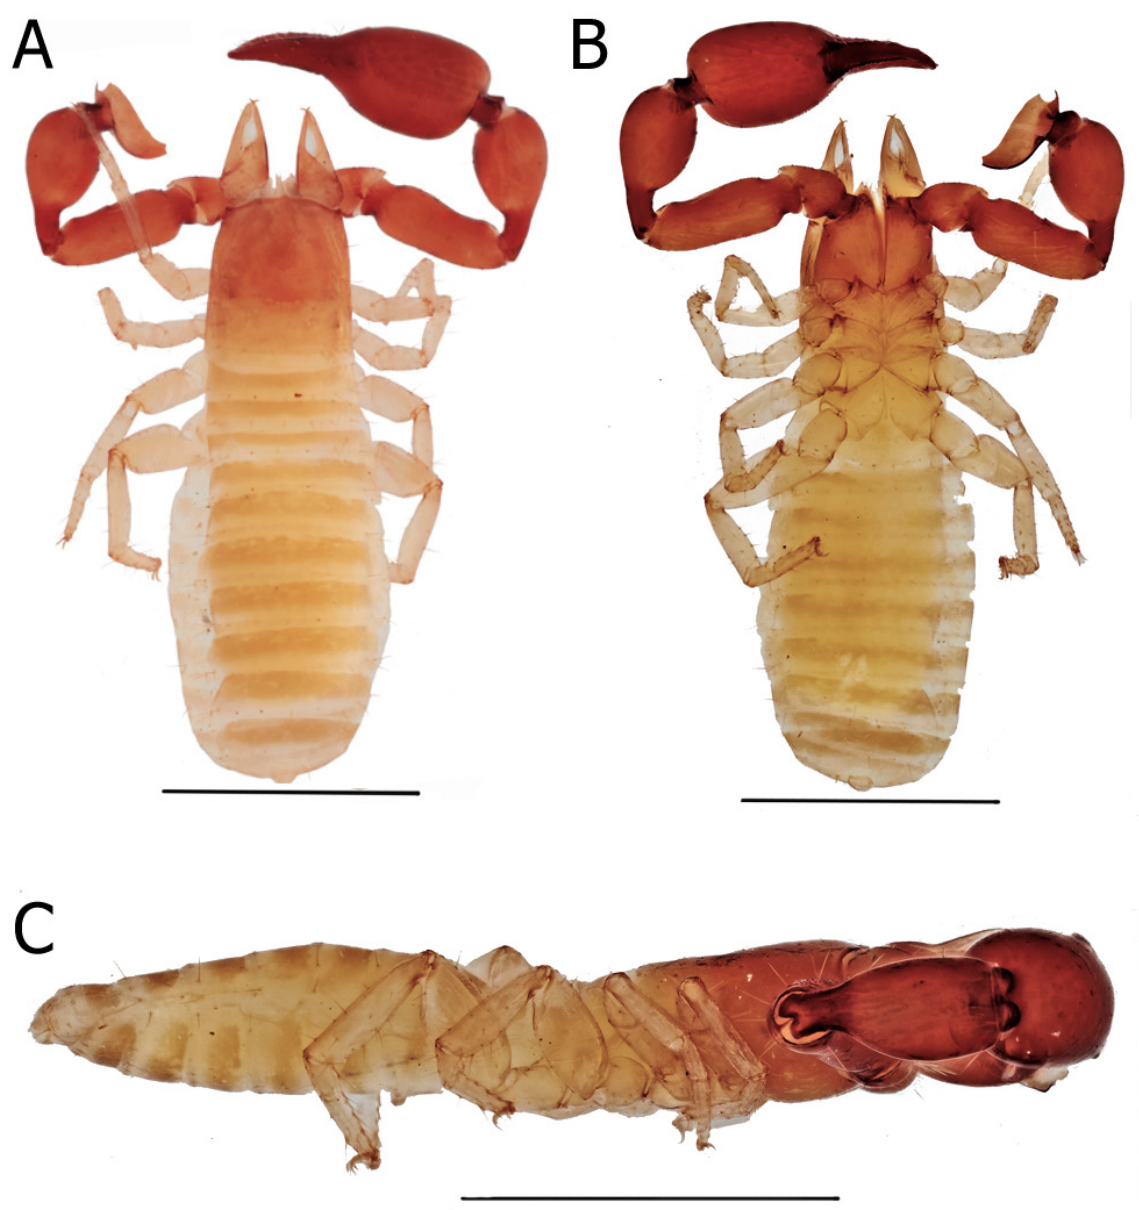
Fig. 26. Ideoblothrus safinai sp. nov., allotype, ♀ (QCAZ). A . Habitus in dorsal view. B . Habitus in ventral view. C . Habitus in lateral view. Scale bars = 1